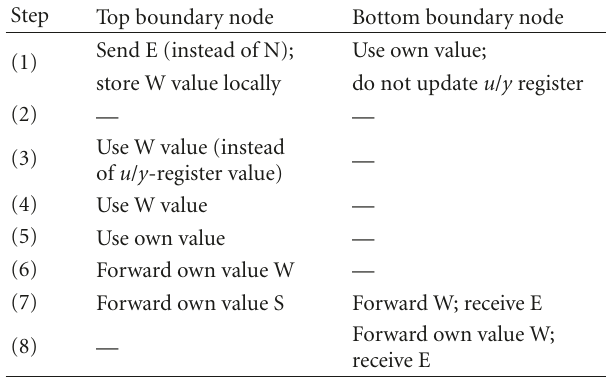
Table 4: Additional actions in boundary nodes remove the need of virtual